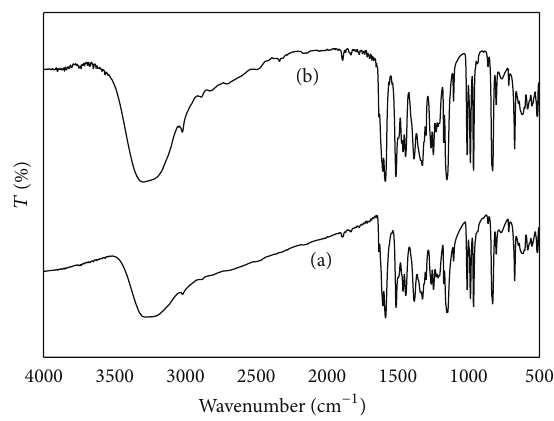
Figure 5: FTIR spectra of r-Res (a) and u-Res